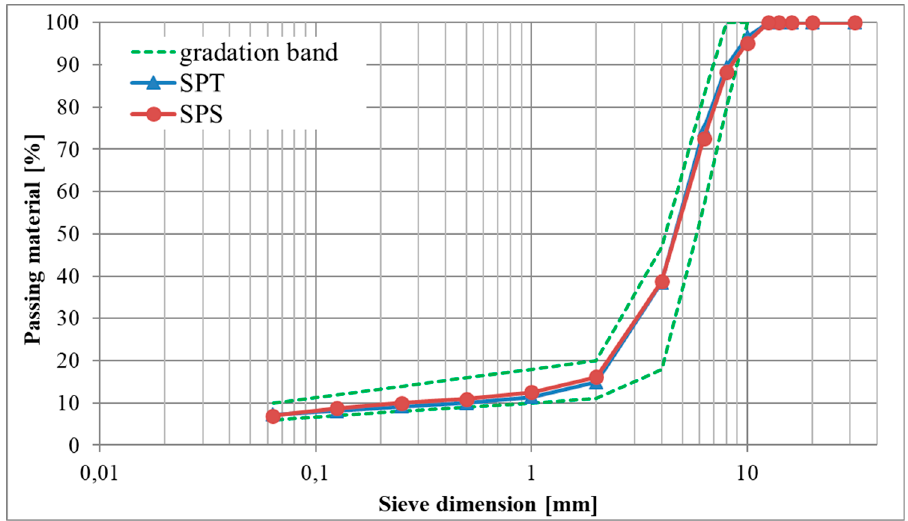
Figure 3. SPT and SPS particles distributions and gradation limits.